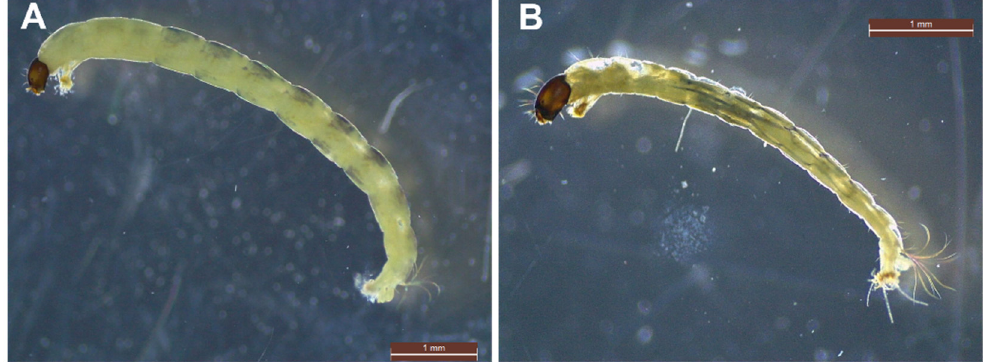
Figure 4. Microphotographs of individuals from family Chironomidae: ( A ) Cricotopus sp., ( B ) subfamily Orthocladinae.